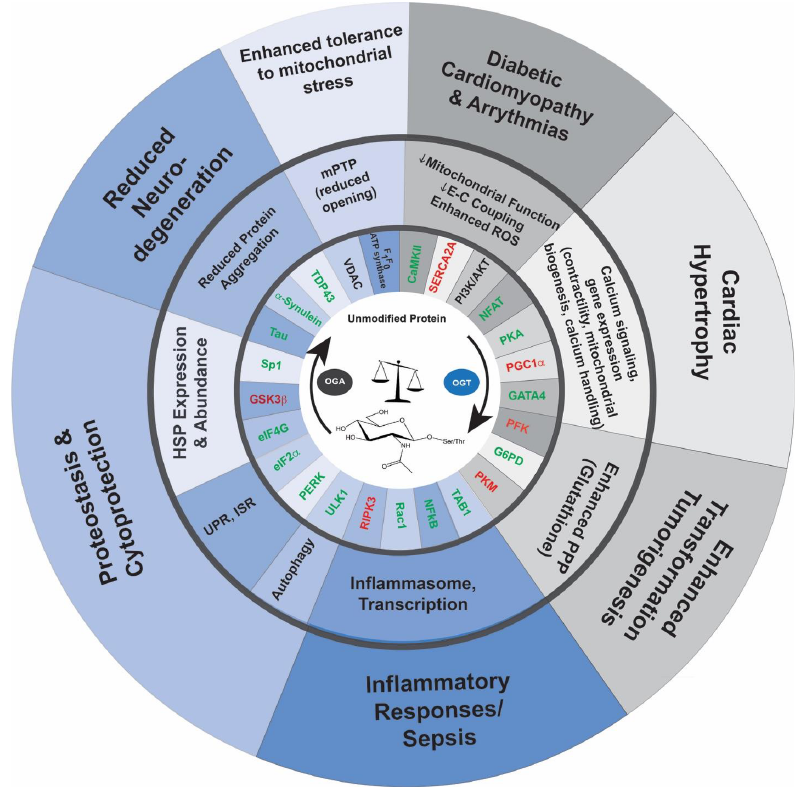
Figure 2. Mechanisms of Protection and Pathogenesis. Dynamic cycling of O-GlcNAc plays numerous roles in regulating cellular homeostasis and the response to cellular injury (blue). In contrast, chronic elevation or depletion of O-GlcNAc resulting in aberrant O-GlcNAc cycling is associated with disease pathogenesis (grey), including cardiomyopathy. Proteins whose function is potentiated by O-GlcNAc are highlighted in green, whereas those whose function is inhibited are highlighted in red. Glycoproteins impacted by O-GlcNAc through ill-defined mechanisms are identified in black. Abbreviations used in this figure: AKT: Protein kinase B; CaMKII: Calcium/calmodulin-dependent protein kinase II; E-C: Excitation-contraction; eIF2 α : Eukaryotic translation initiation factor